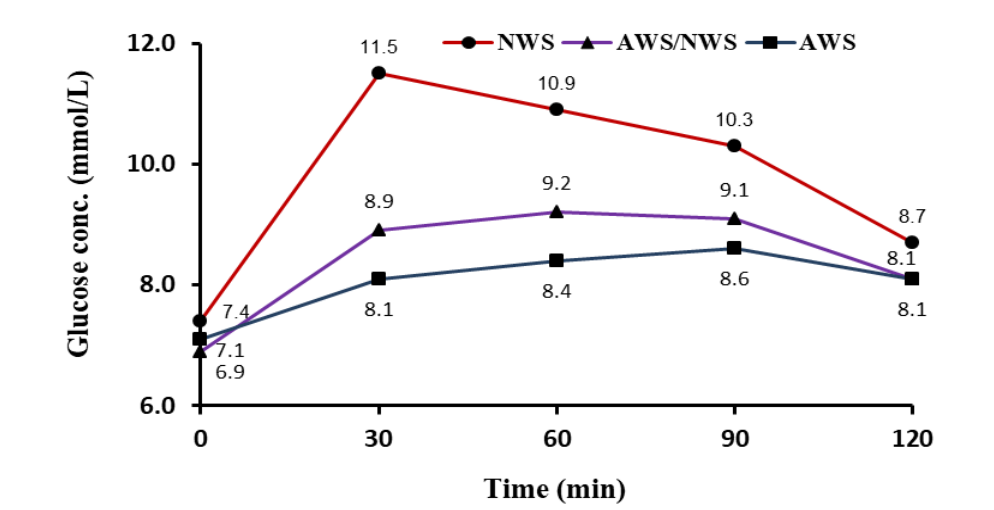
FIGURE 1 - Postprandial glucose concentrations of three experimental mice groups.